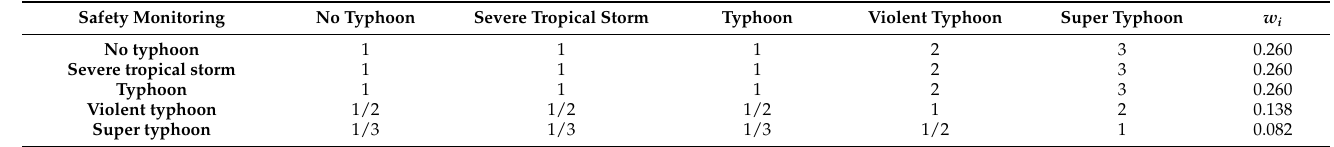
Table 13. Important degree judgment matrix for safety monitoring under different typhoon intensity.